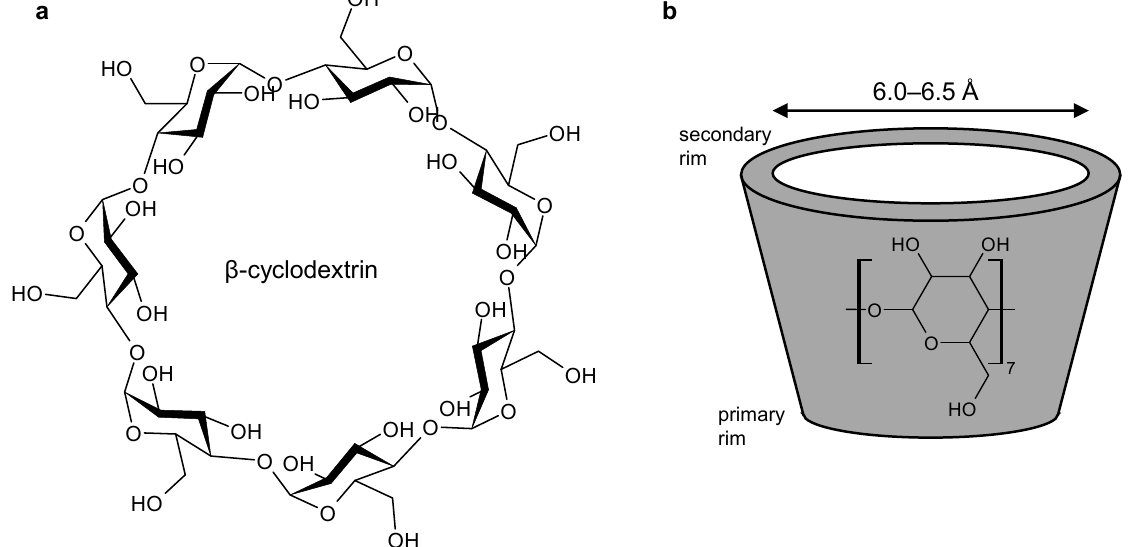
Figure 2. ( a ) Structural formula of β -cyclodextrin; ( b ) sketch of the truncated cone formed by β -cyclodextrin with the size of the cavity.